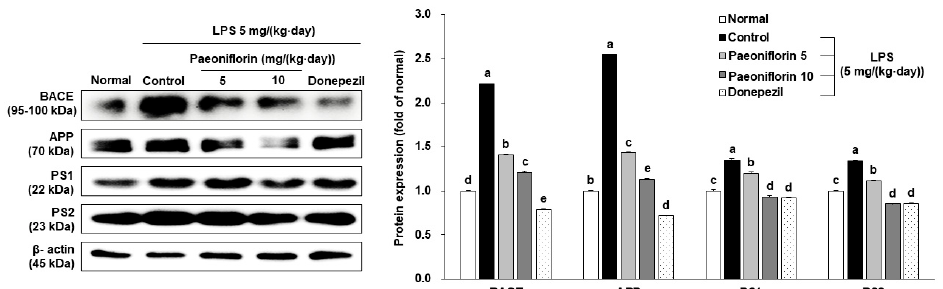
Figure 5. Effects of paeoniflorin on amyloidogenesis-related protein expression in the brain of LPS-injected mice. Western blotting and quantitative analysis of BACE, APP, PS1 and PS2 protein expression levels in the brain. Data represent the mean ± SD. a–e Means with different letters are significantly different ( p < 0.05) by a Duncan’s multiple range test. β -actin served as the loading control. Normal group = 0.9% NaCl i.p. ; Control group = LPS (5 mg/(kg ∙ day)) i.p. + 0.9% NaCl i.p. ; Paeoniflorin 5 group = LPS (5 mg/(kg ∙ day)) i.p. + paeoniflorin (5 mg/(kg ∙ day)) i.p. ; Paeoniflorin 10 group = LPS (5 mg/(kg ∙ day)) i.p. + paeoniflorin (10 mg/(kg ∙ day)) i.p. ; Donepezil group = LPS (5 mg/(kg ∙ day)) i.p. + donepezil (5 mg/(kg ∙ day)) i.p.